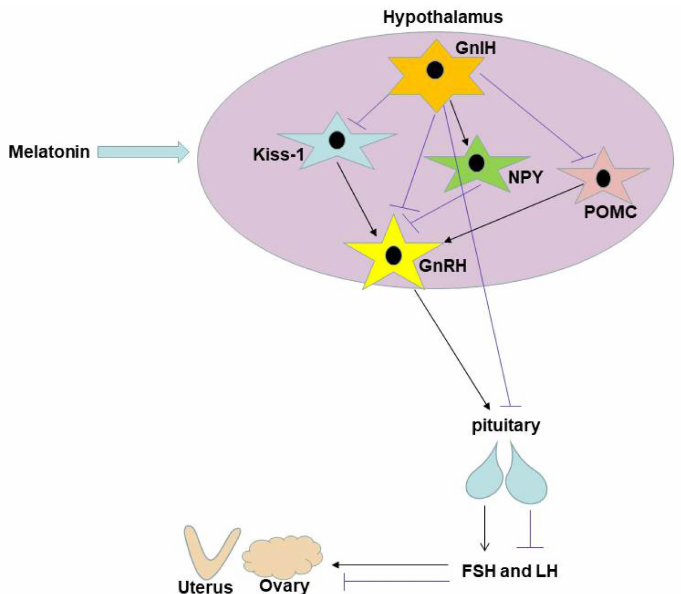
Figure 7. The melatonin mediating delayed puberty pattern